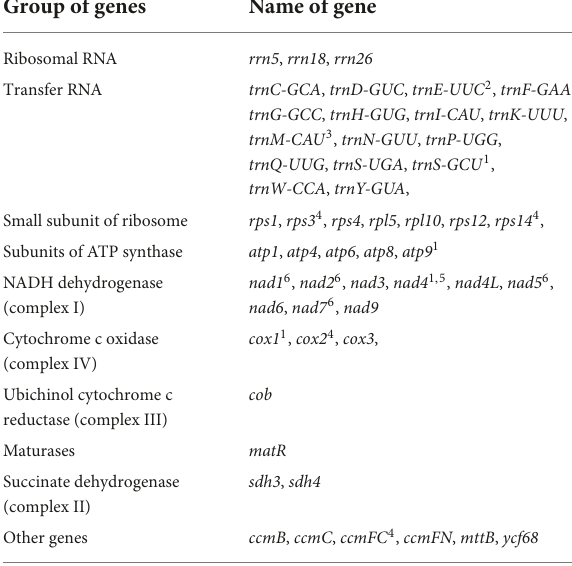
TABLE 1 Annotated genes in the Rhododendron × pulchrum mitochondrial